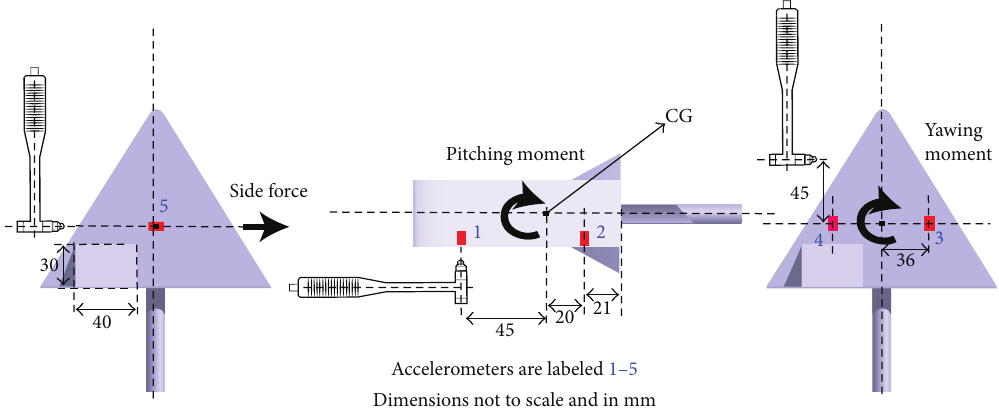
Figure 5: Dynamic calibration (impulse loading) procedure for side force, pitching, and yawing moments.